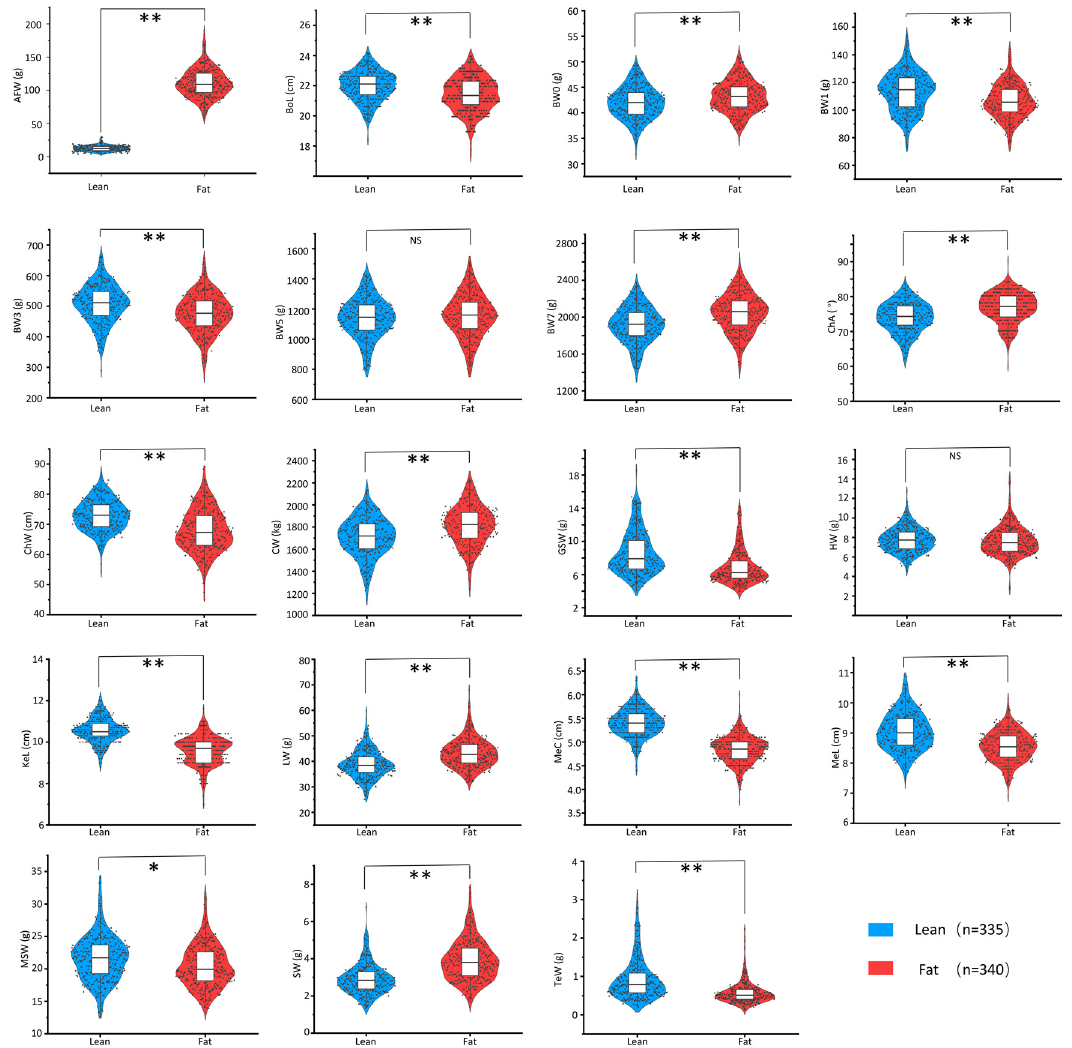
Figure 2. Phenotypic information regarding the growth and body composition traits in NEAUHLF.